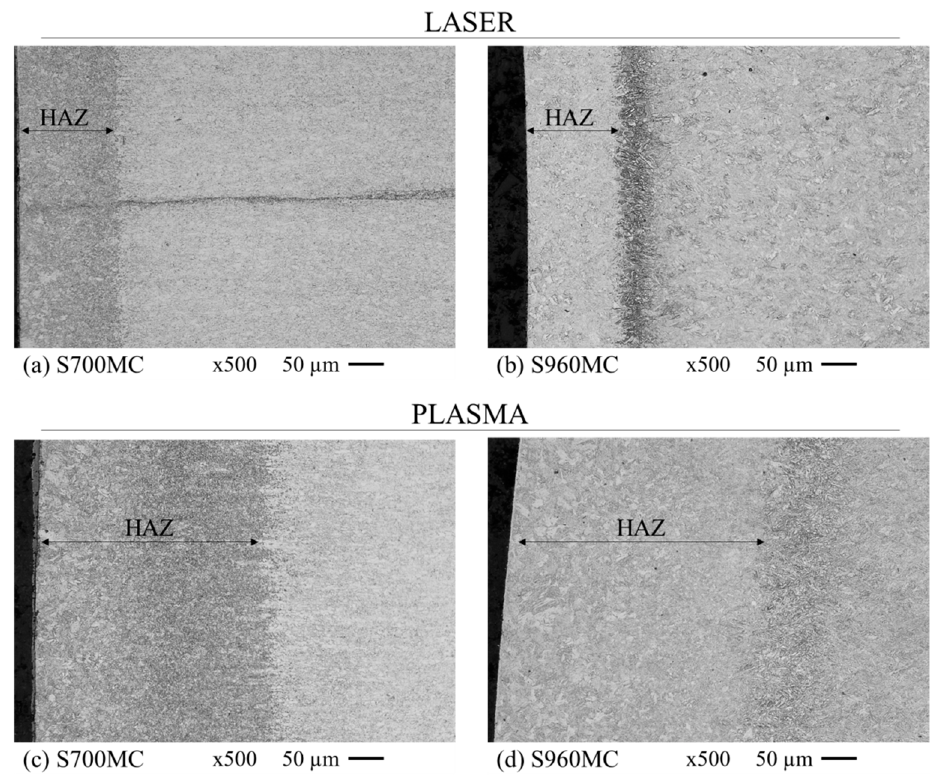
Figure 6. Cross-section of thermal-cut holes: ( a,b ) Laser and ( c,d ) plasma.